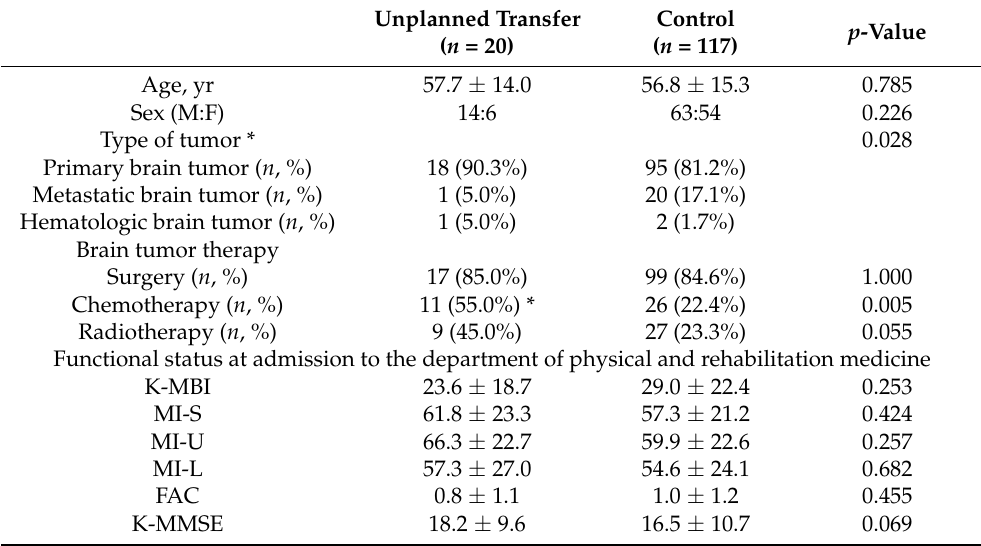
Table 3. Comparison between the unplanned transfer group and the control group in brain tumor